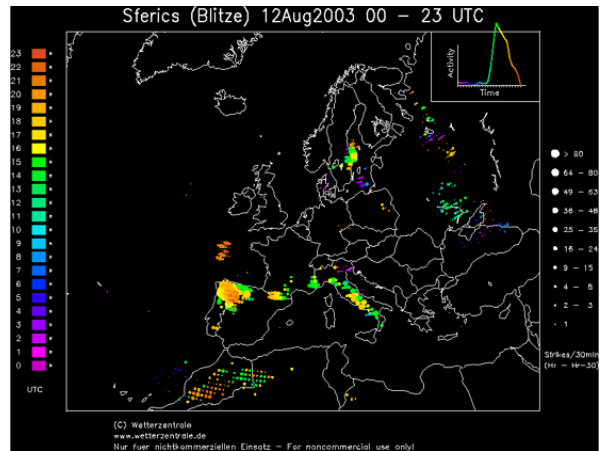
Fig. 11. Date: 12 August 2003, CL4. Spatial, temporal and inten- sity distribution of lightning events.